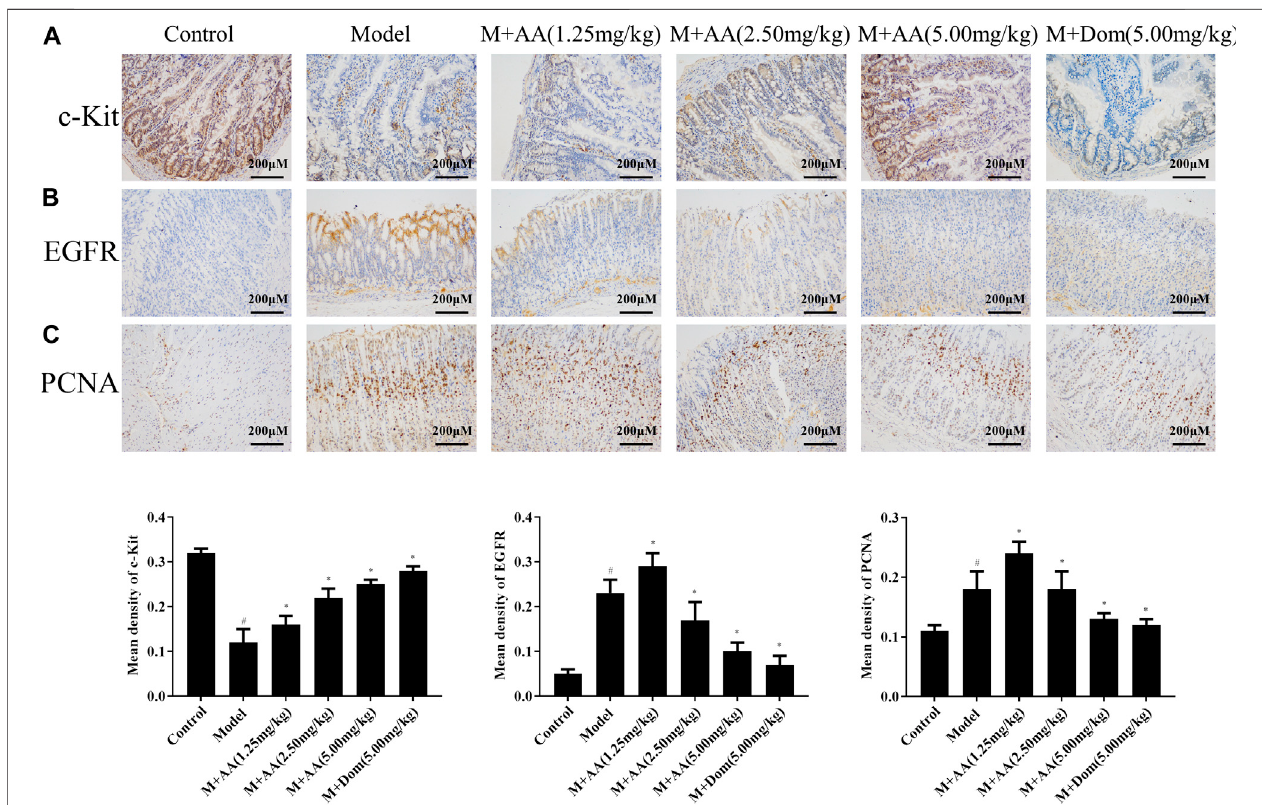
FIGURE3| c-Kitproteinexpression intheintestine, andPCNAandEGFRproteinexpression ingastrictissuesofSDSratstreatedwithAA( n (cid:2) 10).Representative images of intestinal tissue sections ( × 200 magni fi cation) stained with antibodies speci fi c for (A) c-Kit, (B) EGFR, and (C) PCNA, showing the effects of AA at low (1.25 mg/kg),middle(2.5 mg/kg),andhigh(5 mg/kg) doses,aswellasdomperidone(5 mg/kg).Datarepresented mean ± SD.Resultsareexpressedasthemean ± SD from at least three independent experiments. * p < 0.05, compared with model; # p < 0.05, compared with control.